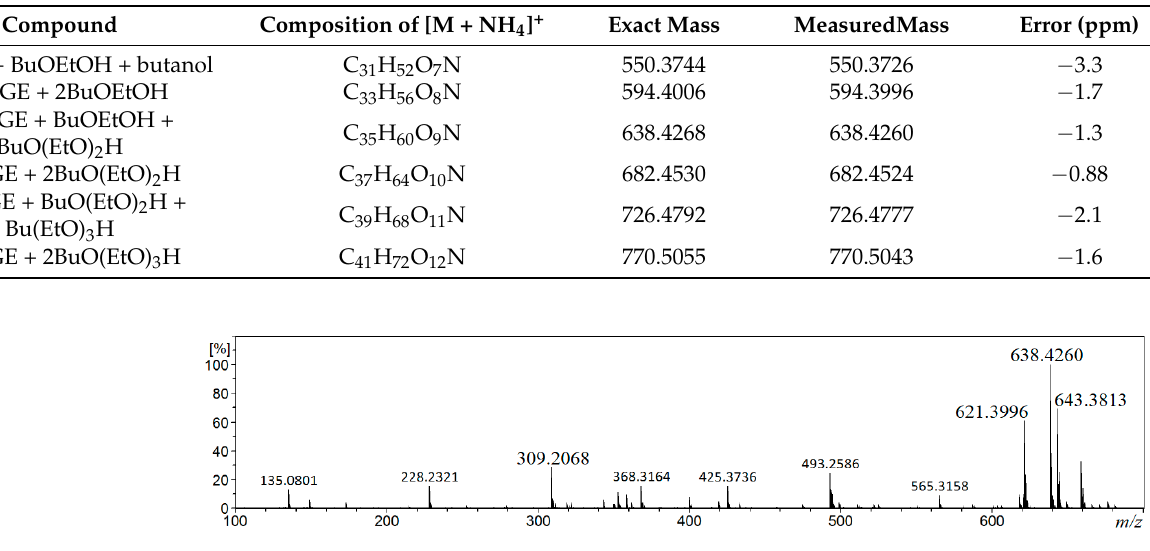
Table 1. Confirmation data of elemental composition of [M + NH 4 ] + ions.